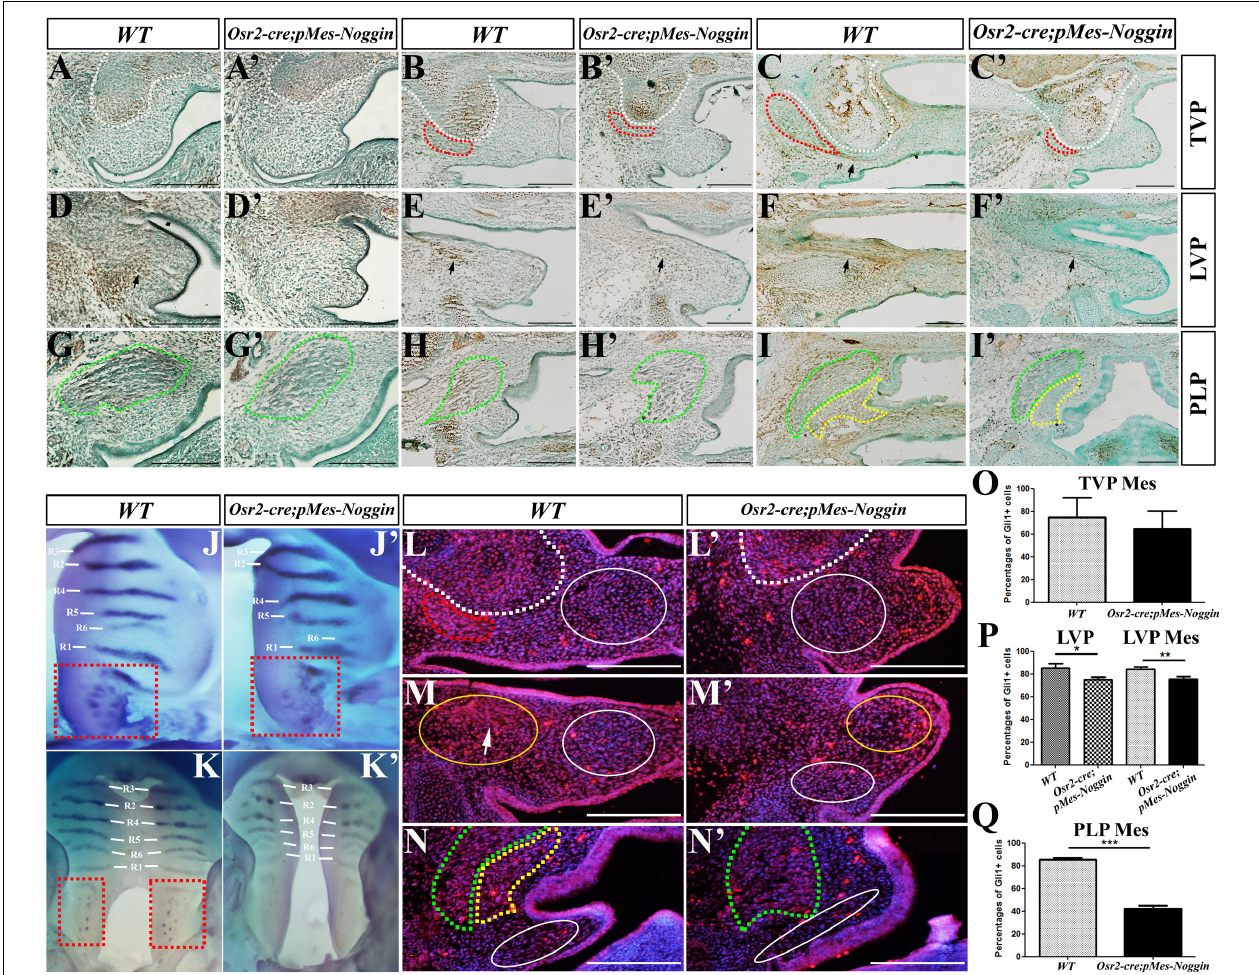
FIGURE 2 | BMP-Smad and Shh-Gli1 signaling in the Osr2-cre KI ;pMes-Noggin soft palates. (A,A (cid:48) –C,C (cid:48) ) The immunostaining of p-Smad1/5/8 at the TVP levels of the E13.5 (A) , E14.5 (B) , and E16.5 (C) WT soft palates, and the E13.5 (A (cid:48) ) , E14.5 (B (cid:48) ) , and E16.5 (C (cid:48) ) Osr2-cre KI ;pMes-Noggin soft palates. The arrow in (C) points to the p-Smad1/5/8 staining in TVP tendon. (D,D (cid:48) –F,F (cid:48) ) The immunostaining of p-Smad1/5/8 at the LVP levels of the E13.5 (D) , E14.5 (E) , and E16.5 (F) WT soft palates, and the E13.5 (D (cid:48) ) , E14.5 (E (cid:48) ), and E16.5 (F (cid:48) ) Osr2-cre KI ;pMes-Noggin soft palates. The arrows point to the LVP regions. (G,G (cid:48) –I,I (cid:48) ) The immunostaining of p-Smad1/5/8 at the PLP levels of the E13.5 (G) , E14.5 (H) , and E16.5 (I) WT soft palates, and the E13.5 (G (cid:48) ) , E14.5 (H (cid:48) ) , and E16.5 (I (cid:48) ) Osr2-cre KI ;pMes-Noggin soft palates. (J,J (cid:48) ,K,K (cid:48) ) Whole-mount in situ hybridization of Shh in the E13.5 (J) and E14.5 WT palates (K) , as well as the E13.5 (J (cid:48) ) and E14.5 Osr2-cre KI ;pMes-Noggin palates (K (cid:48) ) . The R1–R6 delineate the Shh- expressing rugae, and the dashed red boxes circle soft palates with Shh -positive spots. (L,L (cid:48) –N,N (cid:48) ) The Gli1 immunostaining in the E14.5 WT soft palate at the TVP (L) , LVP (M) , and PLP (N) levels, and the E14.5 Osr2-cre KI ;pMes-Noggin soft palate at the TVP (L (cid:48) ) , LVP (M (cid:48) ) , and PLP (N (cid:48) ) levels. The white arrowheads in (M) delineate the LVP region. The white dotted lines delineate the boundary of HPP; the red dotted lines circle the TVP; the green dotted lines delineate the SPCs; the yellow dotted lines circle the PLPs; the white solid circles mean the mesenchymal areas for the statistical assay of the Gli1-positive percentages, while the yellow solid circles in (M,M (cid:48) ) mean the LVP areas for the counting of the Gli1-positive cells. Scale bars are 200 µ m. (O–Q) The statistical assays of the percentages of the Gli1-positive cells in total cells at the E14.5 TVP levels (O) , LVP levels (P), and PLP levels (Q) . The percentage of Gli1-positive cells in the soft palate mesenchyme was 75.05% ± 17.05% and 65.03% ± 15.21% at the WT and Osr2-cre KI ;pMes-Noggin TVP levels, respectively ( p = 0.496; O) . In the WT LVP myofibers, the percentage of Gli1-positive cells was 85.52% ± 3.83%; this percentage was reduced to 75.49% ± 1.77% in the Osr2-cre KI ;pMes-Noggin TVP myofibers ( p = 0.015; P ). Similarly, in the mesenchyme at the LVP levels, the percentage of Gli1-positive cells in WT control was 84.50% ± 1.80%, which was significantly higher than the 75.69% ± 2.33% in the Osr2-cre KI ;pMes-Noggin counterpart ( p = 0.007; P ). At PLP levels, the percentage of Gli1-positive cells was 85.22% ± 1.85% in WT mesenchyme, while it was 42.36% ± 2.31% in the Osr2-cre KI ;pMes-Noggin mesenchyme ( p = 0.0003; Q ). * p < 0.05; ** p < 0.01; *** p < 0.001. Three E14.5 Osr2-cre KI ;pMes-Noggin embryos and their WT littermates were collected for statistical assay. BMP, bone morphogenetic protein; TVP, tensor veli palatini; LVP, levator veli palatini; PLP, palatopharyngeus; HPP, hypophosphatasia; SPC, superior pharyngeal constrictor.